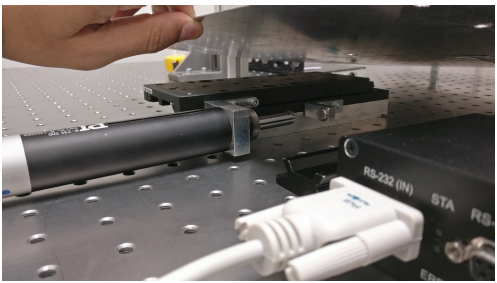
Figure 6. The actuation mechanism showing the actuator attached to a fixed base plate and a moveable spring loaded stage plate. The controller is in the